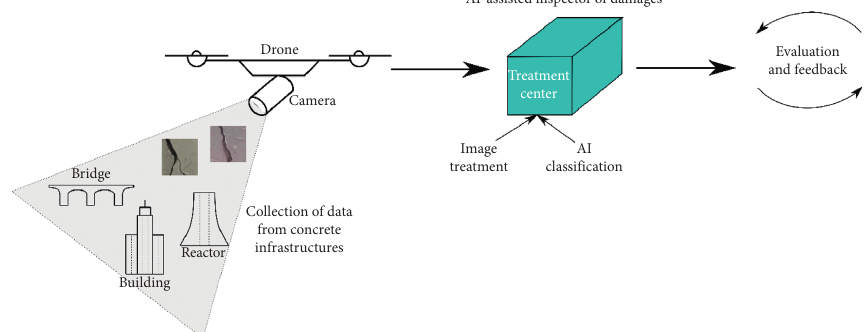
Figure 9: Envisioned working process of AI-assisted damage inspector for concrete